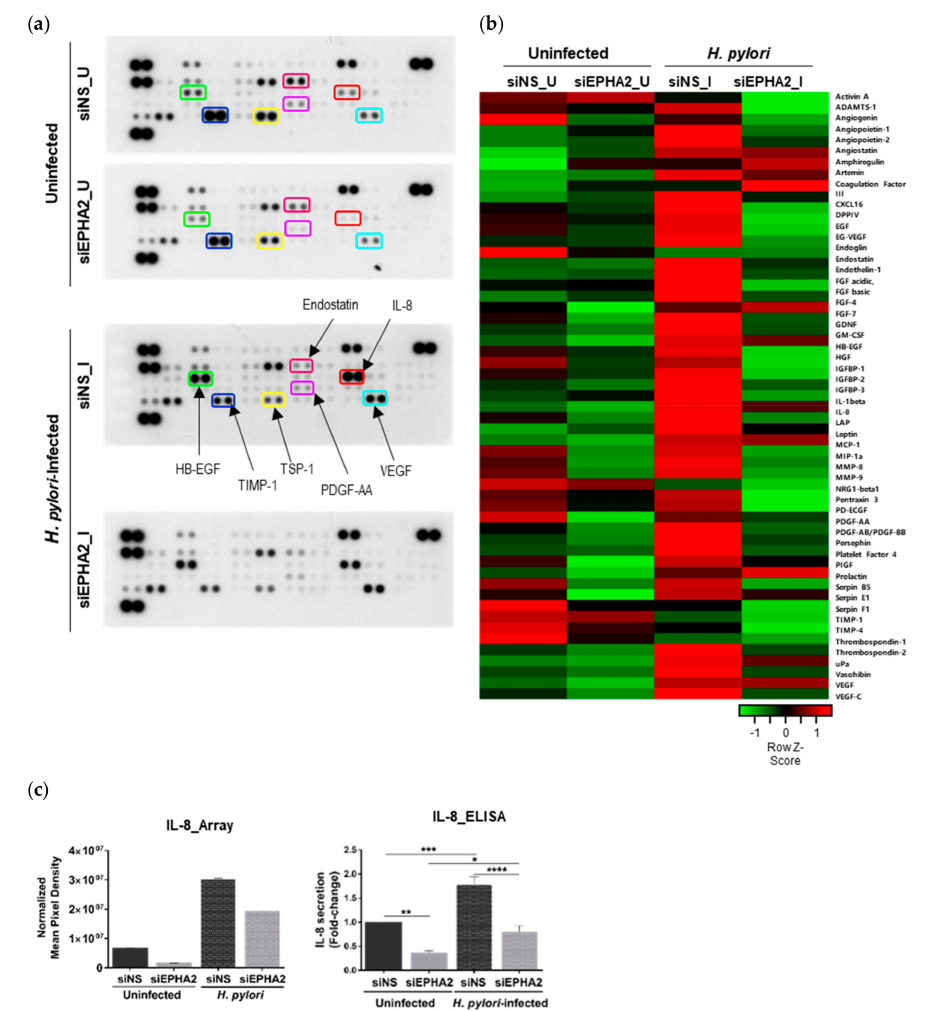
Figure 4. Angiogenic signature imprinted by EPHA2 in gastric cells. ( a ) A human angiogenesis antibody array composed by duplicated spots of 55 angiogenic-related factors was performed with a pool of cell lysates from siNS and siEPHA2-transfected MKN74 and siNS cells-infected with H. pylori 60190 strain (24 h; MOI100) as a control of the angiogenic response ( n = 1); some representative angiogenic factors were highlighted. The map of the array and graph with fold-change variations are presented in Supplementary Figure S1c,d ( b ) Heat map analysis representing the siNS-normalized average pixel density of the duplicated spots for each angiogenic-related protein in the array. ( c ) Validation of the array for IL-8 by ELISA ( n = 6) and its comparison with array expression. One-way ANOVA with post-hoc Tukey’s test for multiple comparisons analysis: **** p < 0.0001; *** p < 0.001; ** p < 0.01 * p ≤ 0.05; ns—not significant ( p >